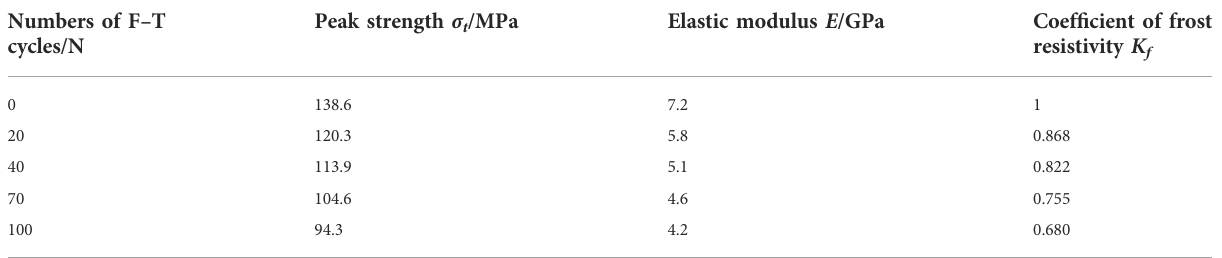
TABLE 3 Uniaxial test results for granite.